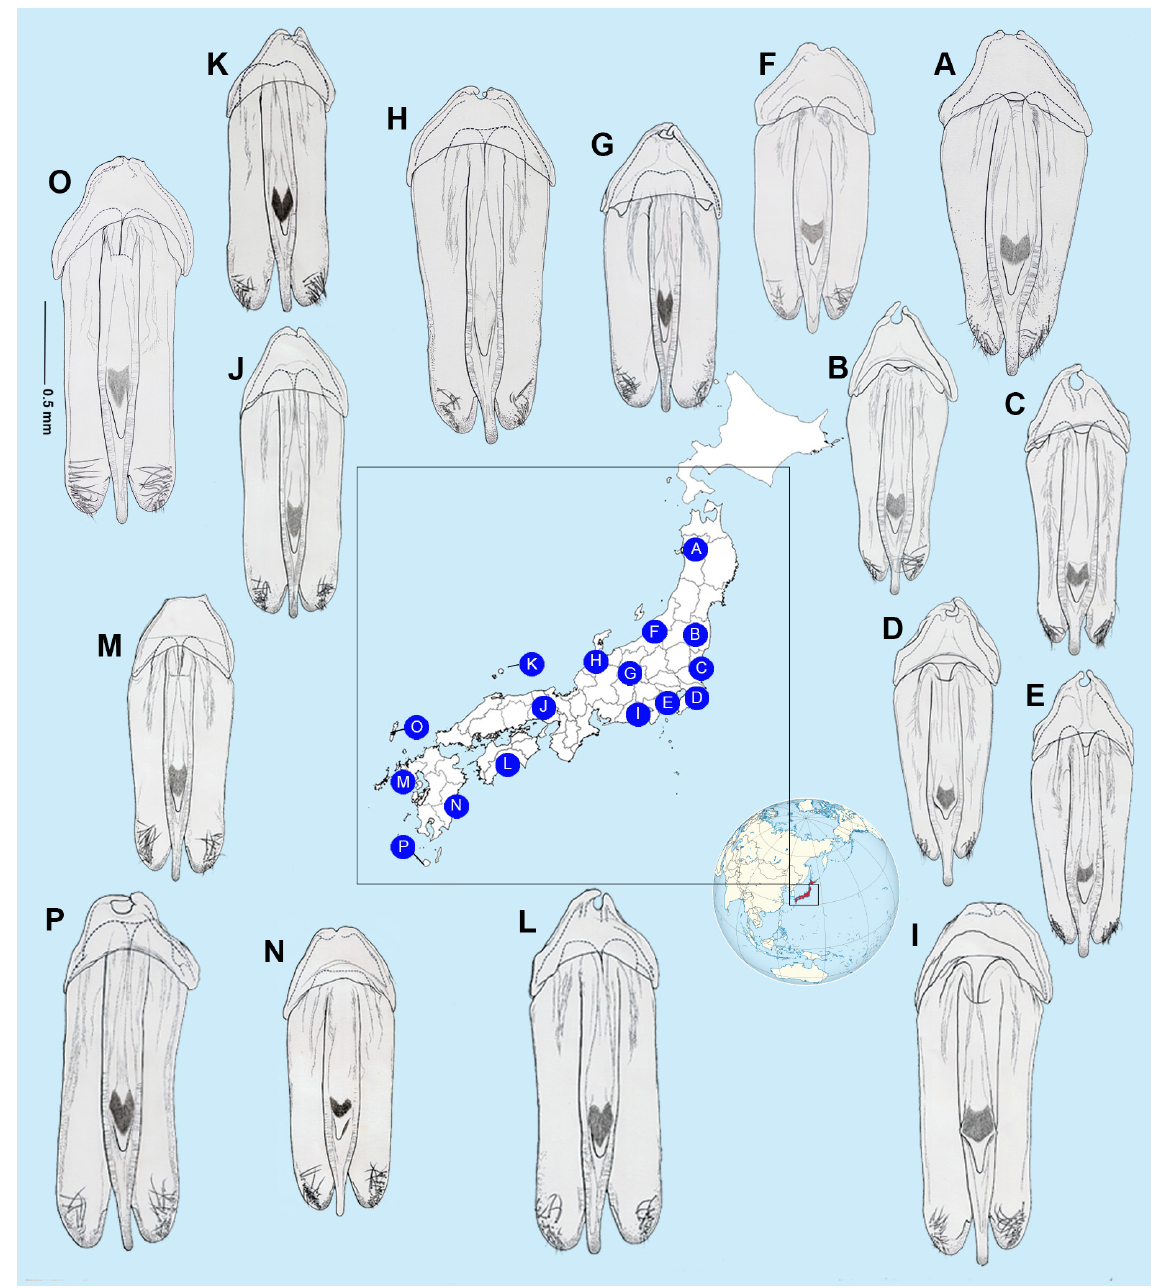
Fig. 11. Distribution of aedeagal patterns of Nipponoluciola cruciata (Motschulsky, 1854) gen. et comb. nov. in the Japanese islands; aedeagus ventral view. Images by I. Kawashima. Map by W.F.A. Jusoh (Map of Japan using base maps obtained from Wikimedia Commons - Maximilian Dörrbecker and Connormah, CC BY-SA 3.0). A . Akita. B . Fukushima. C . Ibaraki. D . Chiba. E . Kanagawa. F . Niigata. G . Nagano. H . Ishikawa. I . Shizuoka. J . Hyogo. K . Oki Islands. L . Kochi. M . Nagasaki. N . Miyazaki. O . Tsushima Island . P . Yakushima